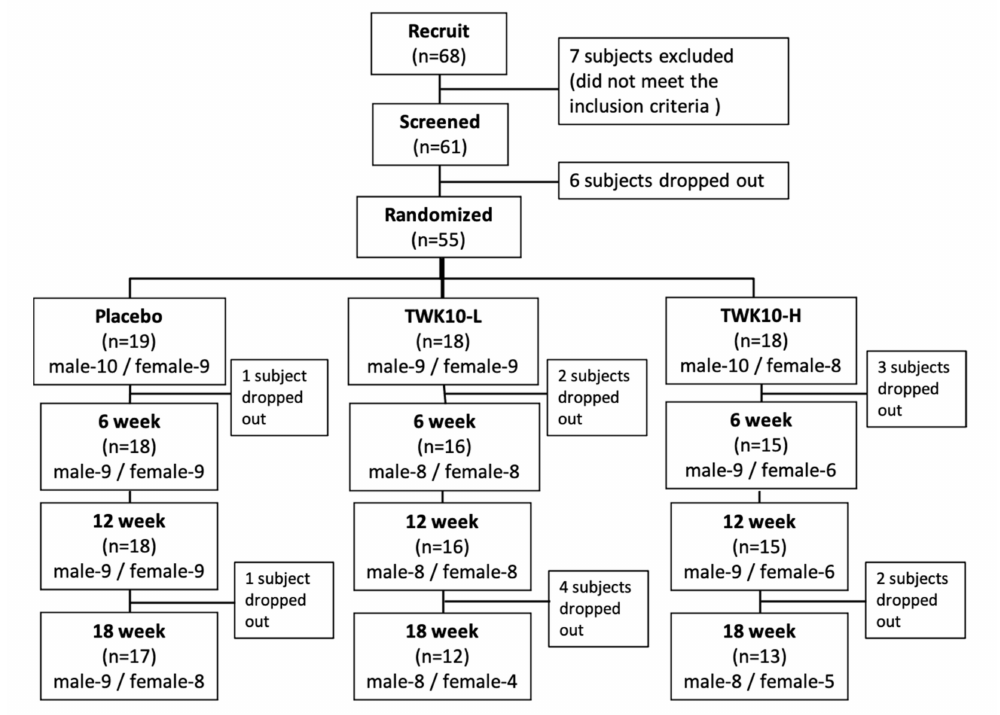
Figure 1. Experimental procedure